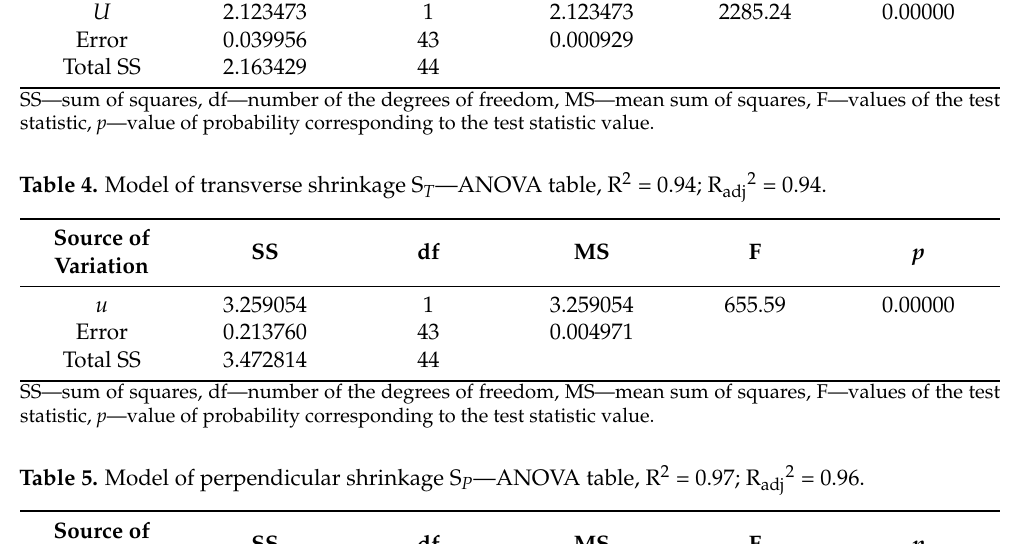
Table 3. Model of longitudinal shrinkage S L —ANOVA table, R 2 = 0.98; R adj2 = 0.98. Source of SS Variation